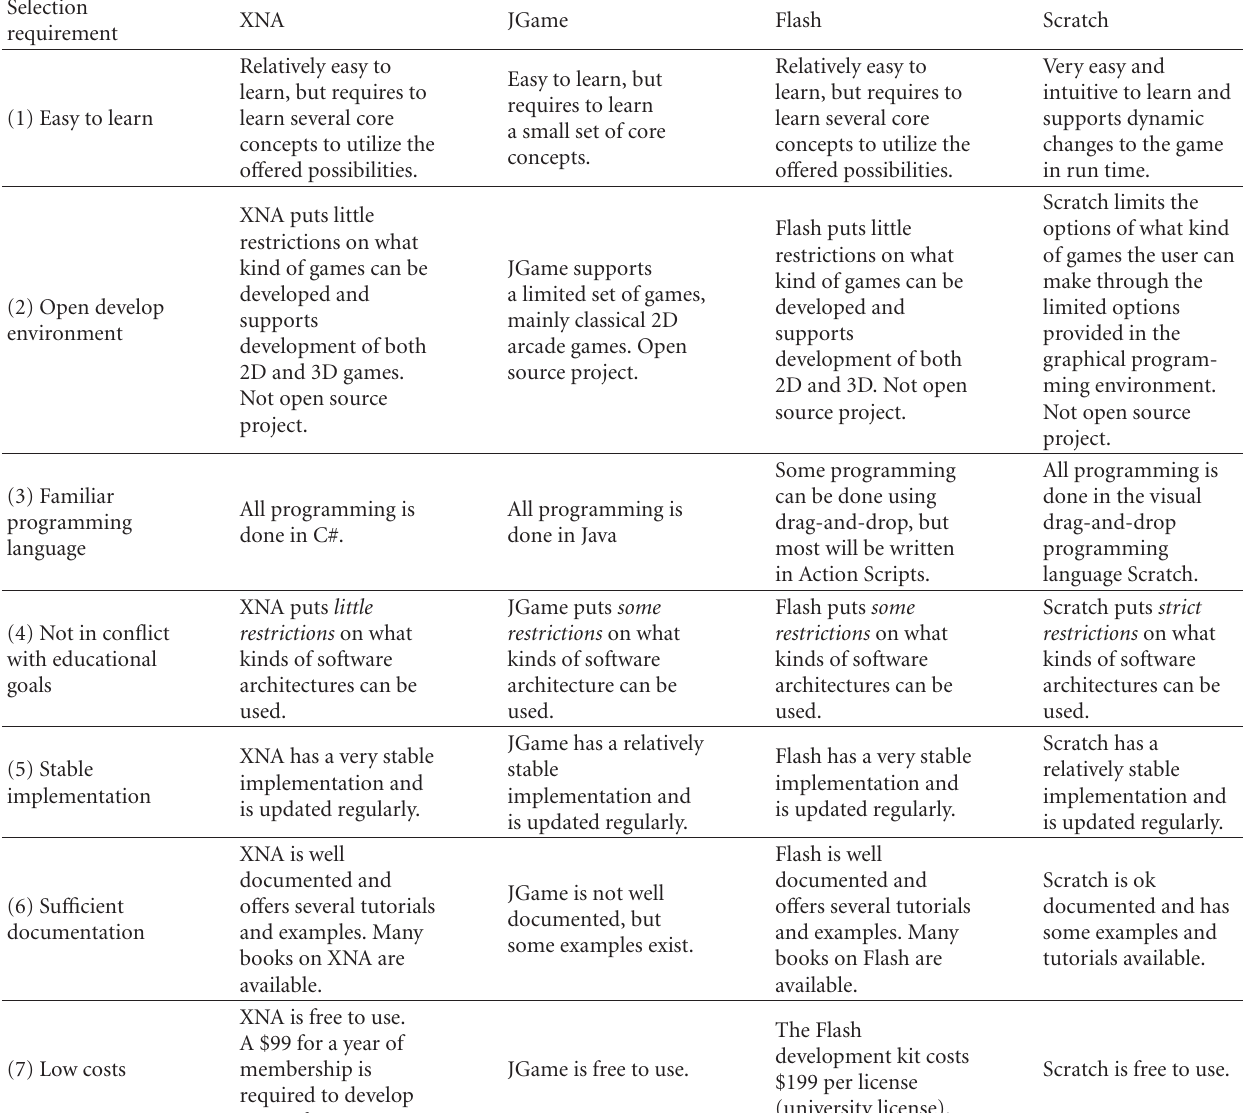
Table 1: Evaluation of four GDF